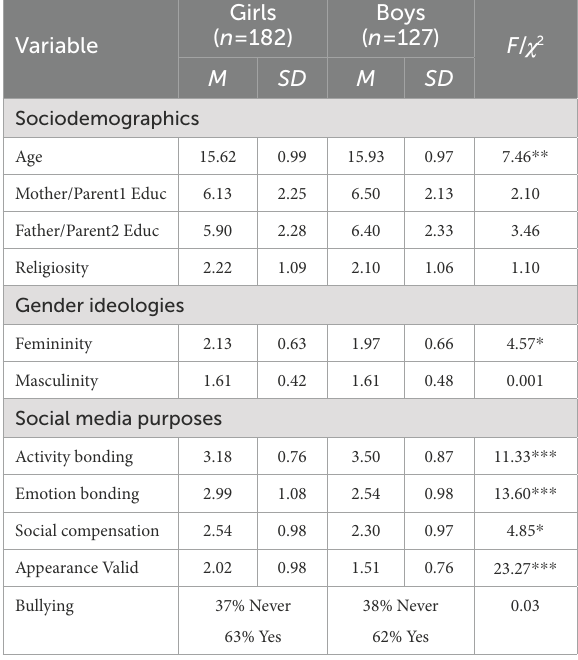
Percentages represent proportions of girls and proportions of boys identifying a particular platform in their top three social media platforms. * p < 0.05. ** p < 0.01. *** p < 0.001. TABLE 2 Gender differences in adolescents’ sociodemographic backgrounds, gender ideologies, and purposes of social media use.